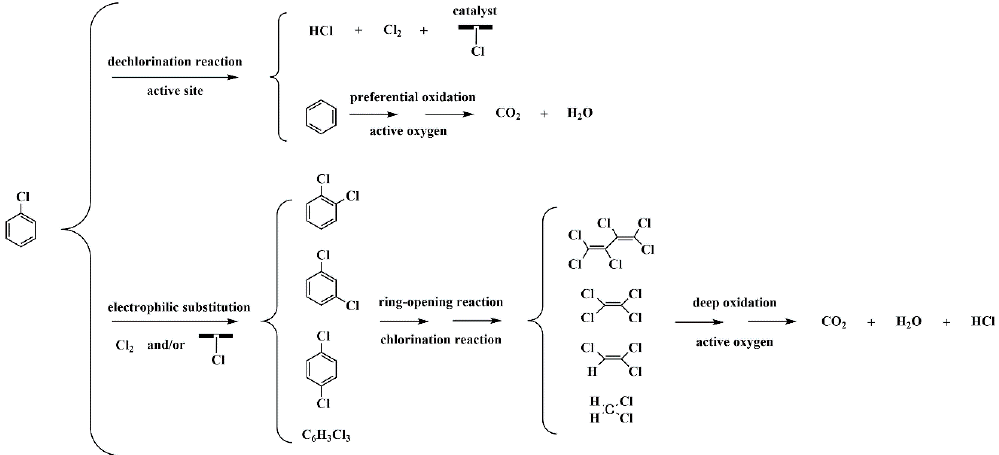
Scheme 1. Proposed reaction path of CB oxidation over the MCZ-0.67 catalyst.